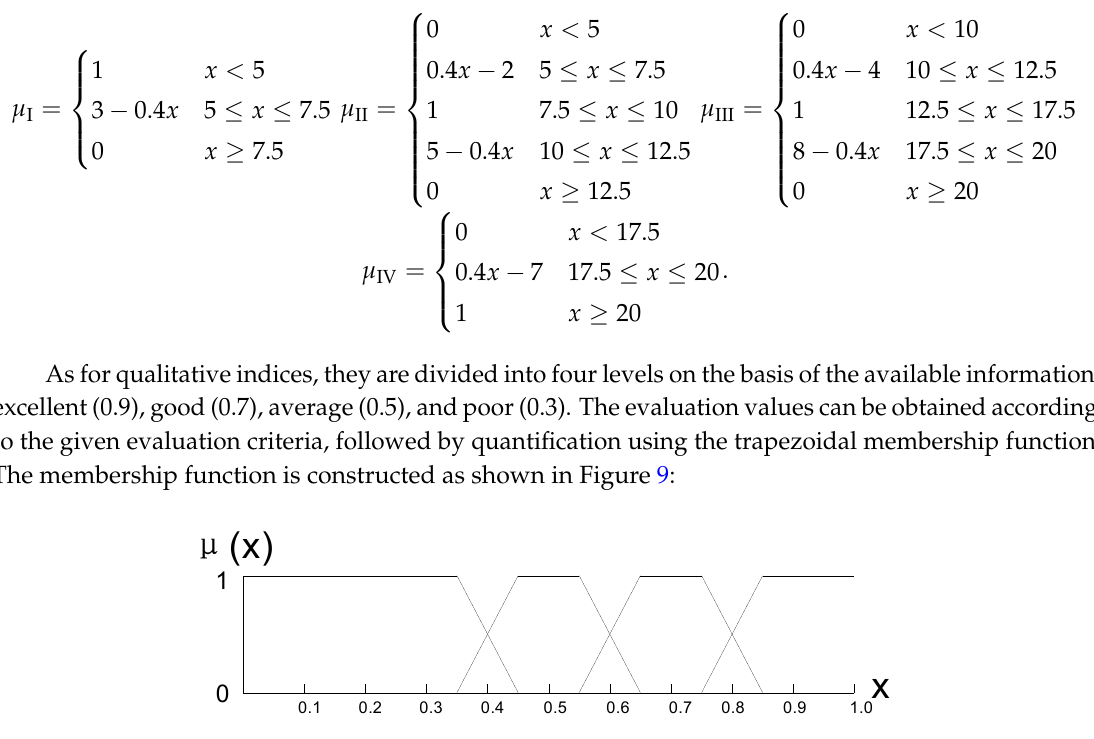
Figure 9. Figure of membership function for qualitative indices.